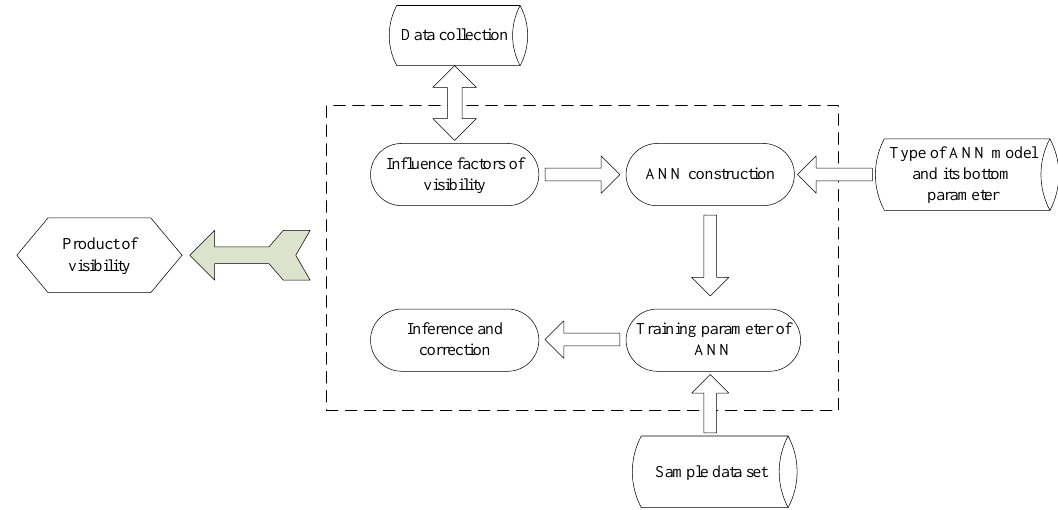
Figure 1. The technical flowchart to infer visibility (Vis) based on artificial neural network (ANN).